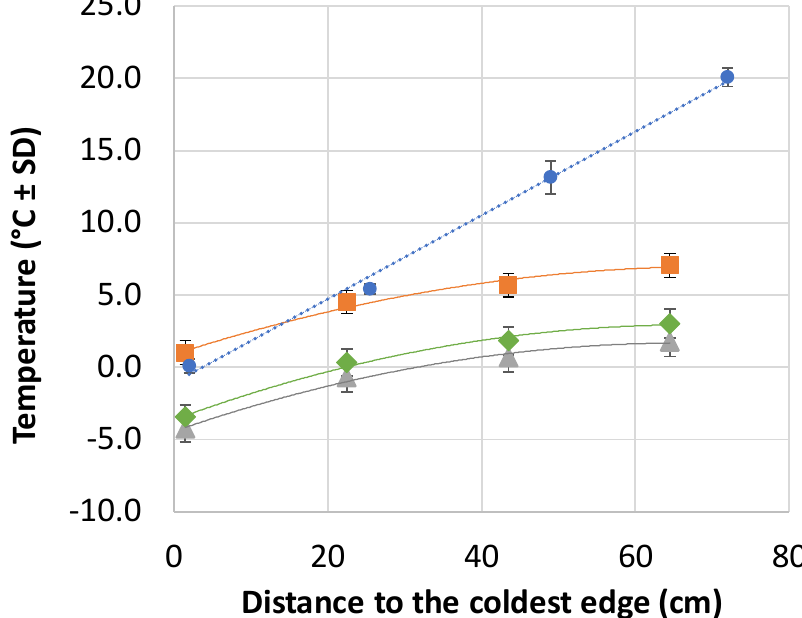
Figure S1 – Temperatures measured throughout the experiment in the thermoelectric plates (Blue circles) and climate cabinet (Orange squares, Green diamonds, and Grey triangles) as a function of distance from the coldest edges. In the thermal bridges, the linear regression connecting the measurements is y = 0.2889x - 0.3452. In the climate cabinet, the polynomial regressions connecting the measurements differed between the warmest (Orange square; y = -0.0012x2 + 0.1714x + 0.8747), intermediate (Blue circle; y = -0.0015x2 + 0.1955x - 3.643) and coldest (Grey triangles; y = -0.0014x2 + 0.1842x - 4.445) temperature